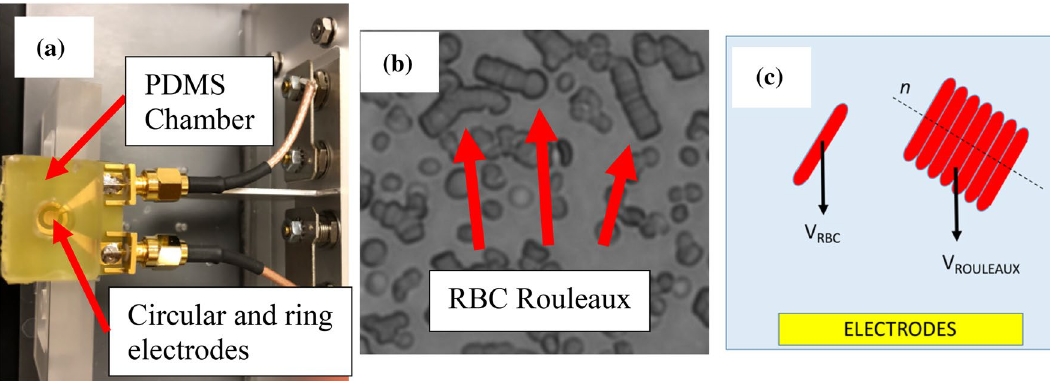
Figure 1. Blood samples were housed in a PDMS chamber and their electrical impedance was measured using circular and ring electrodes as shown in ( a ). As blood is left at hemostasis in autologous plasma, RBCs aggregate to form ‘rouleaux’. A representative microscopic picture of RBC rouleaux is shown in ( b ). As the sedimentation velocity of a particle in low Reynolds number regime is dependent on its radius squared, RBC Rouleaux sediment faster than RBCs. A schematic depicting the cross-section of the chamber is shown in ( c